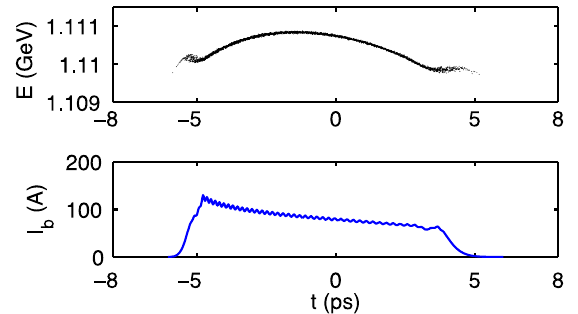
FIG. 8. Microbunching gain spectra with LSC effects. Note